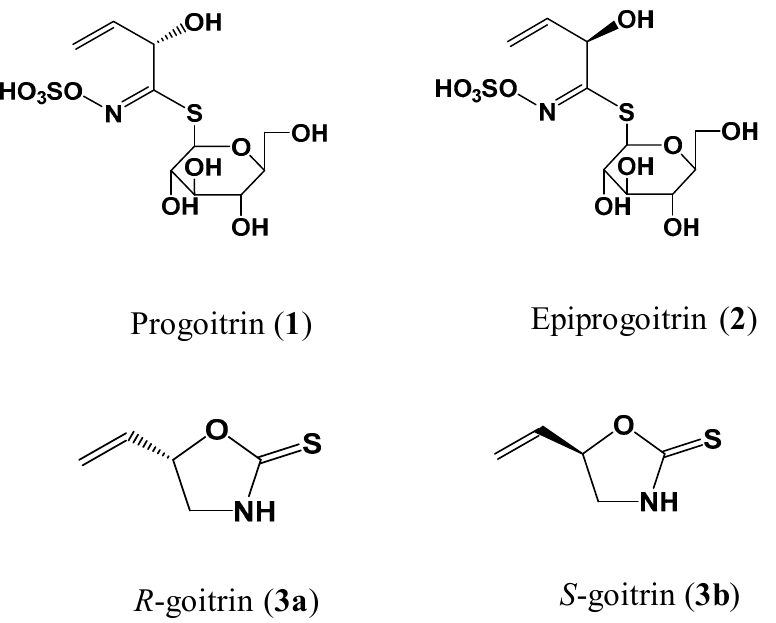
Figure 3. Chemical structures of four characteristic glucosinolates isolated from Radix Isatidis.